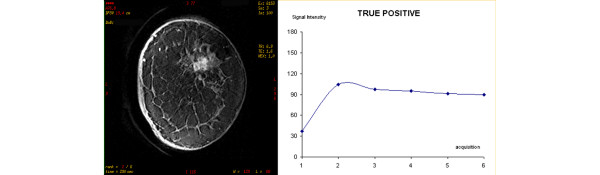
Magnetic resonance mammography 4 years after treatment for invasive ductal carcinoma. This shows a 2 cm lesion (left image), with a signal–intensity curve with early wash-in and late washout (right image) (Breast Imaging Reporting and Data System V) (invasive ductal carcinoma at histology).